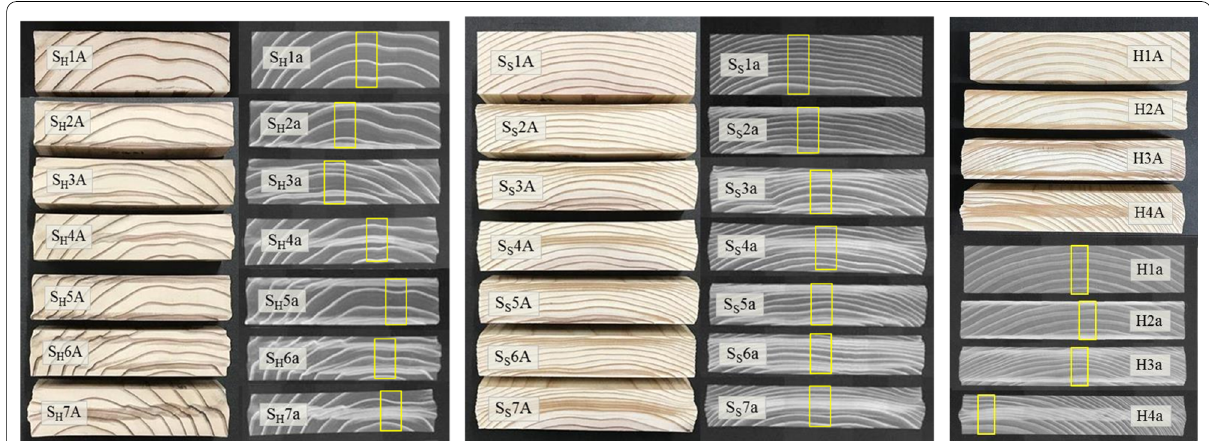
Fig. 2 Photos and soft X-ray images of the transverse section of sugi heartwood, sugi sapwood and hinoki wood. S H , S S , H in the labels represent sugi heartwood, sugi sapwood and hinoki wood. Labels containing ‘1 ′ represent the control specimens. Labels containing ‘2 ′ , ‘3 ′ , and ‘4 ′ , respectively, represent the sandwich timbers with surfaces compressed (preheating time: 15 s), interior compressed (preheating time: 180 s) and center compressed (preheating time: 1500 s) when the compression is 6 mm or 5 mm; ‘5 ′ , ‘6 ′ , ‘7 ′ in the labels represent the sandwich wood with surface compressed, interior compressed and center compressed when the compressing distance is 10 mm; labels containing ‘A’ represent photos; labels containing ‘a’ represent X-ray images; sections in the yellow rectangle are the area where the density was